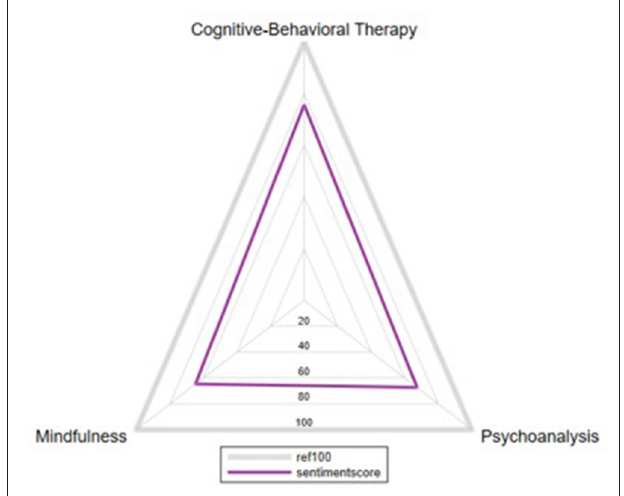
FIGURE 1 | Sentiment analysis of each type of psychotherapy analyzed. The average score obtained by all the tweets with a certain hashtag determines the overall score of each food group (Cognitive-Behavioral Therapy, 75.69, Psychoanalysis, 67.3, Mindfulness,